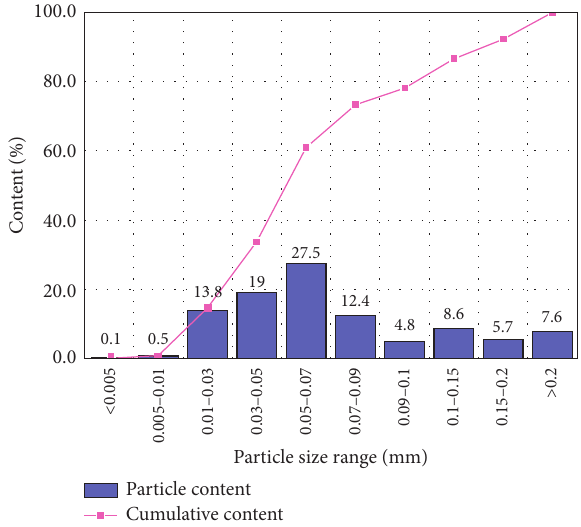
Figure 12: Particle size distribution of dolomite and calcite.